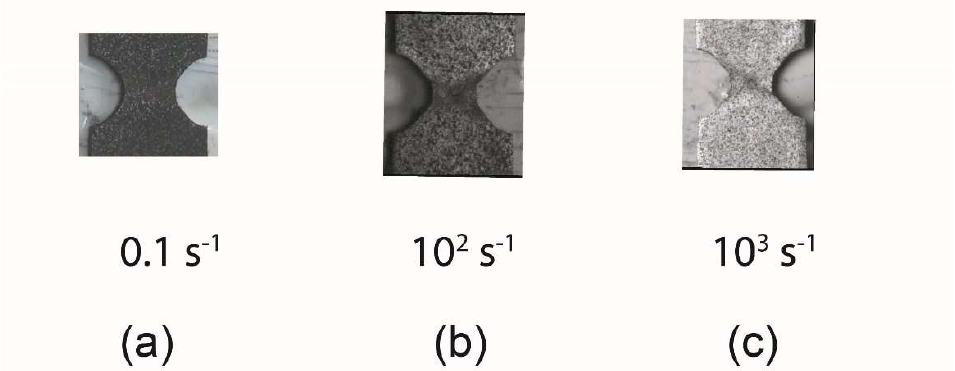
Figure 7. Geometry of specimens with an initial notch radius of 2.5 mm at the moment of time preceding the formation of a macrocrack under tension at a strain rate of ( a ) 0.1 s -1 , ( b ) 100 s -1 , and ( c ) 1000 s -1 .